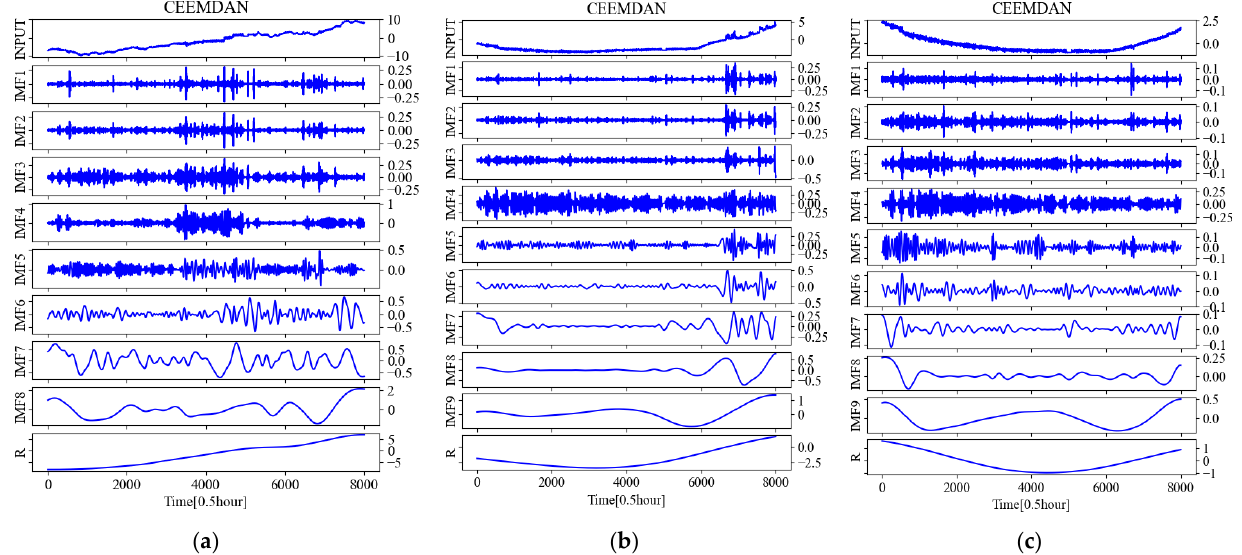
Figure 11. Results of temperature decomposed by CEEMDAN at different subgrade depths. ( a ) 0.5 m depth; ( b ) 1.5 m depth; ( c ) 2.9 m depths. The temperature time series were processed by EMD, EEMD, and CEEMDAN, re- spectively, then reconstructed into a hybrid dataset that contains the volumetric water content time series (H) and frost heave time series (D) of the corresponding depths. After that, the hybrid dataset was put into the LSTM model training, to get the optimal model, and to then make predictions. The specific prediction results are shown in Figure 12.